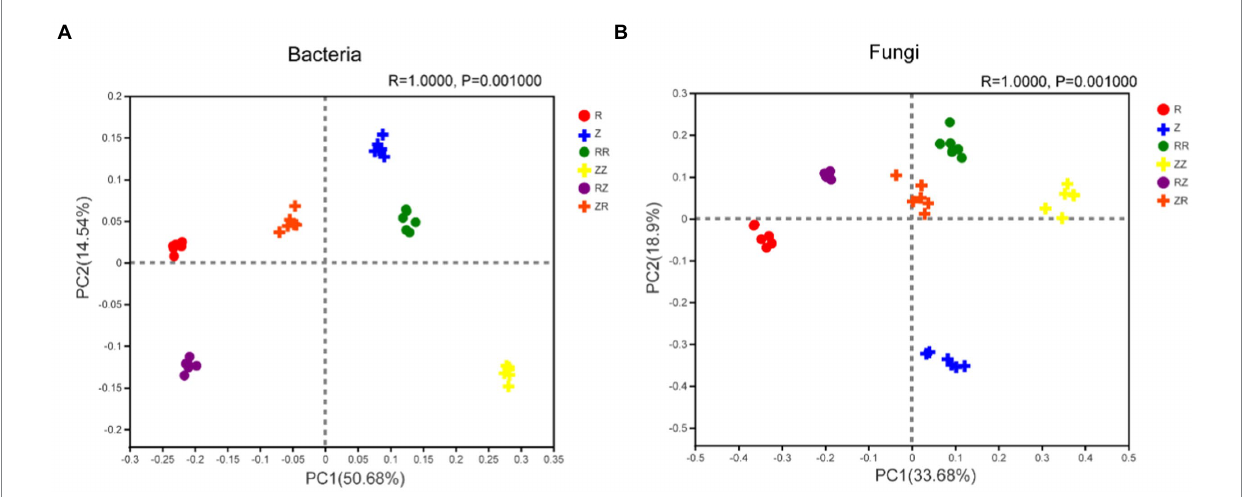
FIGURE 4 Response of sugarcane straw returning on the Principal Coordinates analysis (PCoA) of bacterial (A) and fungal (B) community structure of different sugarcane cultivars. R: cultivar ROC22, RR: cultivar ROC22 plus straw of ROC22; RZ: cultivar ROC22 plus straw of Zhongzhe9; Z: cultivar Zhongzhe9;